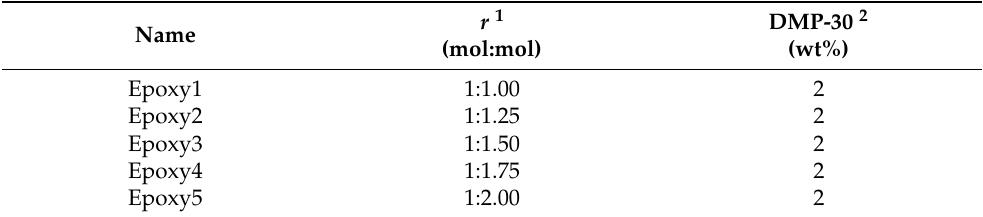
Table 1. Formulations of diglycidyl ether of bisphenol A (DGEBA)/-glutaric anhydride